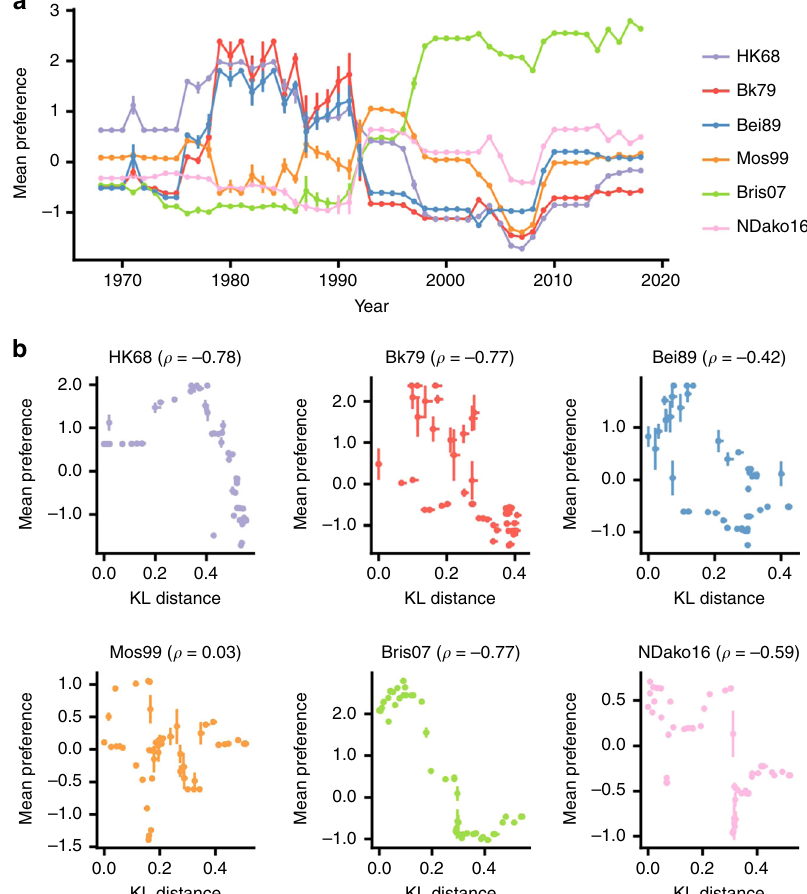
Fig. 3 The local fi tness landscape of antigenic site B coevolves with the genetic background. a The variant preference for each naturally occurring variant was computed based on different genetic backgrounds. The average variant preference for different strains in a given year is shown. Different genetic backgrounds are represented by different lines, which are color coded as indicated on the right. Error bars represent the standard error of mean. A total of 45,218 human H3N2 strains isolated from 1968 to 2018 were analyzed. A schematic representation of this analysis is shown in Supplementary Fig. 4. b The divergence of sequence variants in natural strains from the focal year in each panel is calculated by the residue-averaged Kullback – Leibler (KL) divergence (see Methods). The entire HA sequence except residues 156, 158, 159, 190, 193, and 196 was used for calculating KL divergence. The relationship between the sequence divergence and the variant preference on the given genetic background is shown. Spearman rank correlation ( ρ ) between sequence divergence and the variant preference for each for each of the focal genetic background is shown in parentheses. The vertical error bar represents the standard error of the mean of the variant preference. The horizontal error bar represents the 95% con fi dence intervals for the estimated KL divergence based on a parametric bootstrap. In most cases, the 95% con fi dence intervals are quite tight. Source data are provided as a Source Data fi